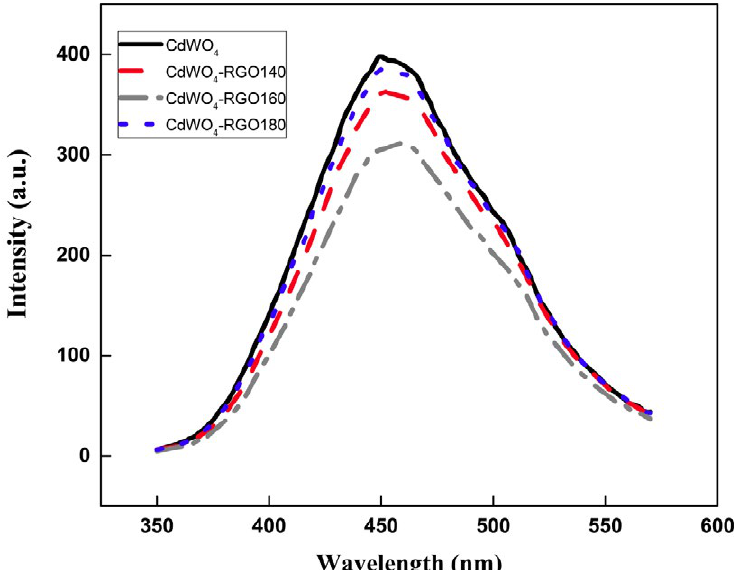
Fig. 7. Room-temperature PL spectra of the pure CdWO